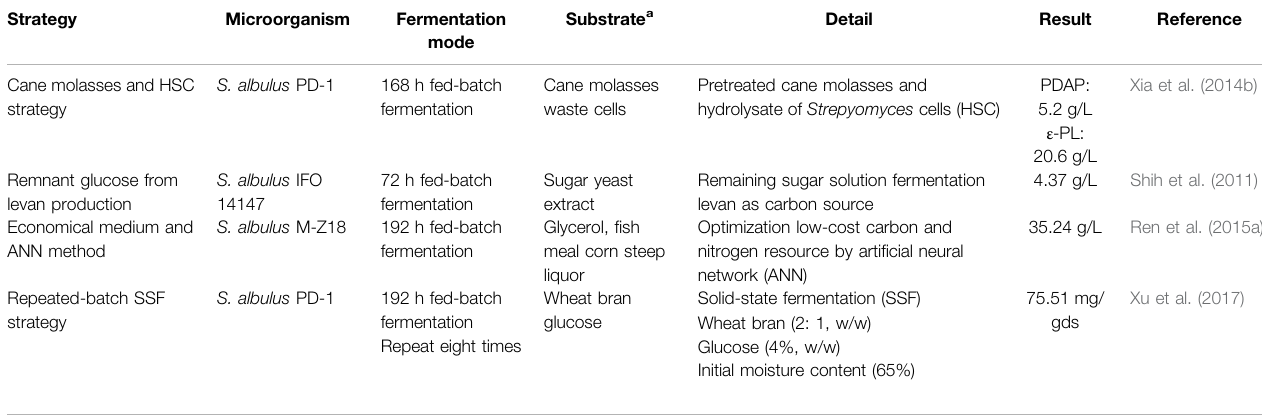
TABLE 2 | ( Continued ) Summary of the process engineering strategies on ε -PL